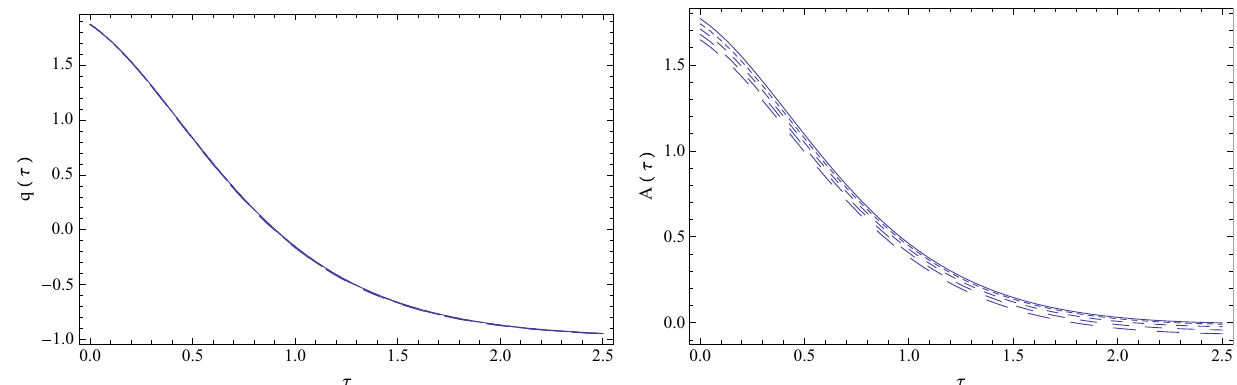
= 0 . 277 ( long dashed curve ), respectively. The initial conditions μ Fig. 2 Variationofthedecelerationparameter q ( leftfigure ), andofthe 0 anisotropyparameter A ( rightfigure )foraBianchitypeIUniversefilled used to numerically integrate the cosmological evolution equations are V ( 0 ) = 0 . 8, u ( 0 ) = 4, B 0 ( 0 ) = 0 . 7,and b 0 ( 0 ) = − 0 . 001,respectively. withastifffluidintheMaxwell–Chern–Simonstheory,fordifferentval- ues of the parameters λ 1 and μ 0 : λ 1 = 0 . 11, μ 0 = 0 . 447 ( solid curve ), In all cases the numerical value of the parameter λ 2 has been fixed as λ λ = 0 . 12, μ = 0 . 377 ( dotted curve ), λ = 0 . 13, μ = 0 . 333 ( short = 0 . 1 0 1 0 2 dashed curve ), λ 1 = 0 . 14, μ 0 = 0 . 301 ( dashed curve ), and λ 1 = 0 . 15,